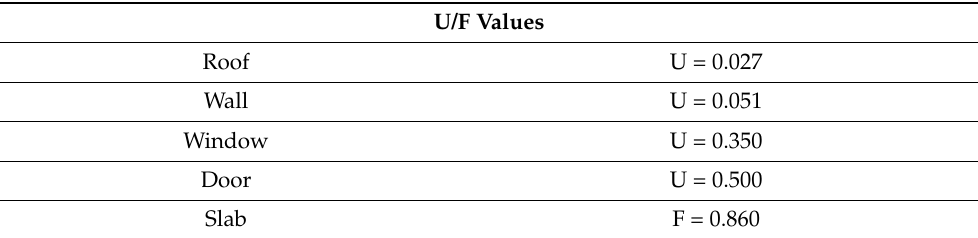
Table 7. ASHRAE 90.1 Required Assembly U and F Values for Climate Zone